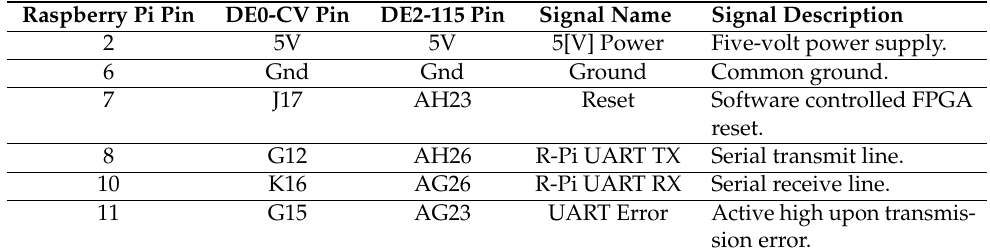
Table 2. Raspberry Pi pin connects.